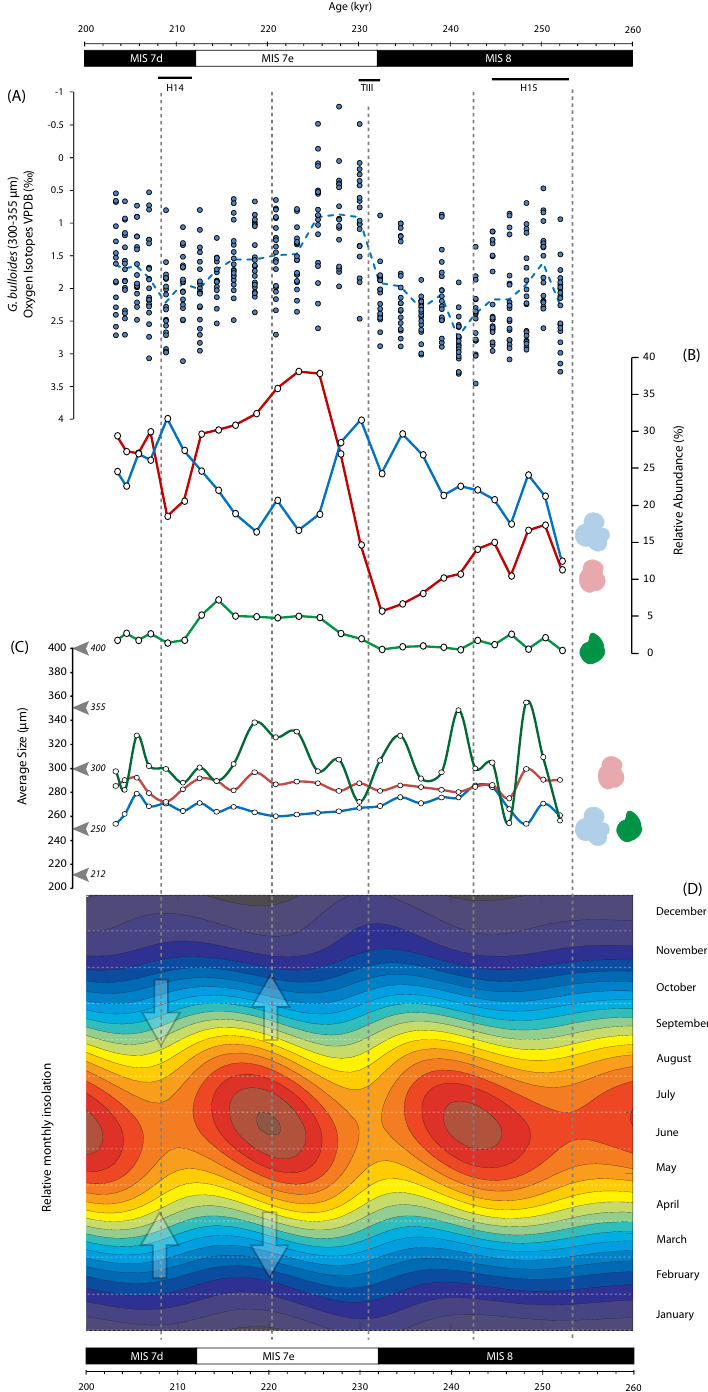
Figure 3. Relative abundance and average size of planktonic foraminifera across MIS7 to 8. (a) G. bulloides single-specimen δ 18 O values, for reference; the dashed line represents average δ 18 O values. (b) Relative abundance of the whole sample of G. bulloides (blue), G. inflata (red) and G. truncatulinoides (green) used to calculate the average size (c) ; arrows in (c) denote the upper and lower limits of the size fractions used in this study. In comparison with abundance and average size, the relative monthly insolation (d) for the time period has been plotted. Arrows in (d) represent expansion and contraction of increased summer insolation. Dashed vertical lines indicate the minima and maxima in insolation; horizontal bars at the top specify samples that contain Heinrich/IRD (ice-rafted